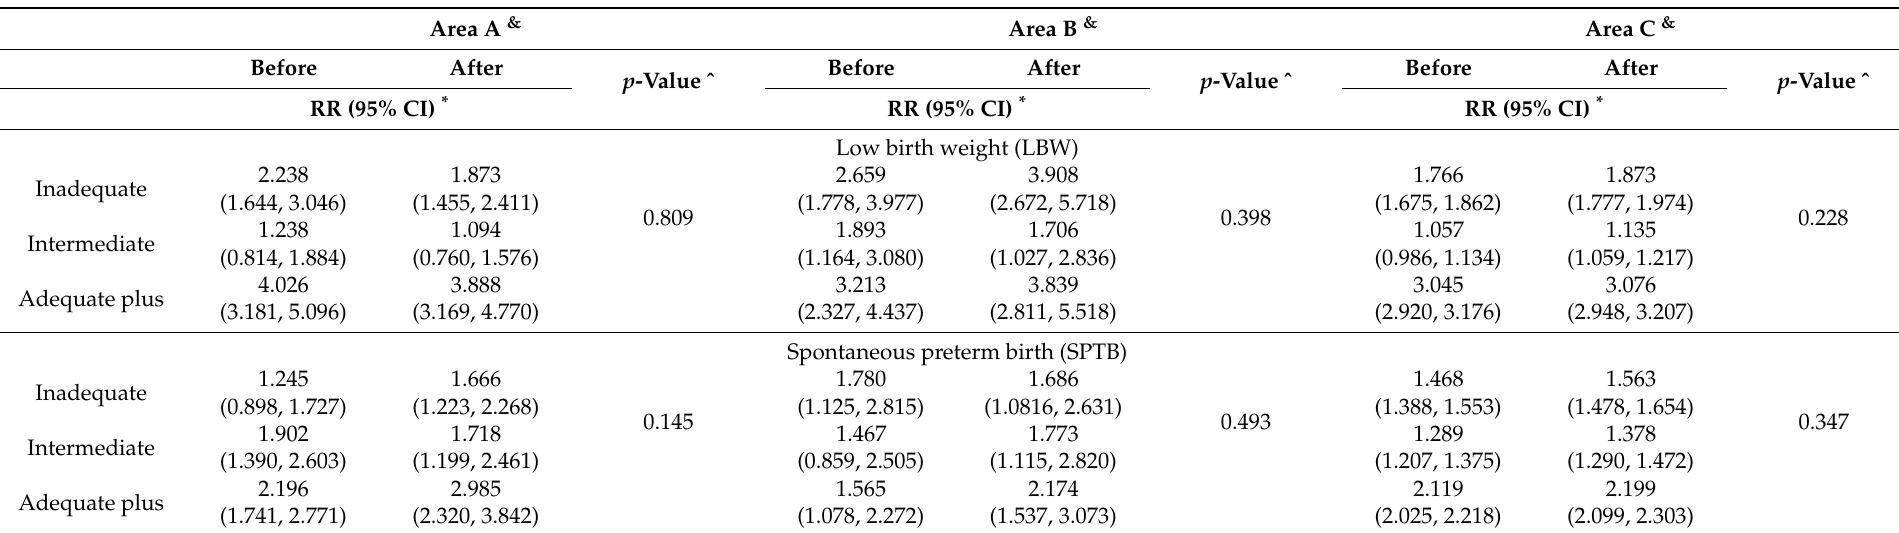
Table 4. The association between Kotelchuck Index and perinatal outcomes before and after Hurricane Michael # . Area A & Area B & Area C